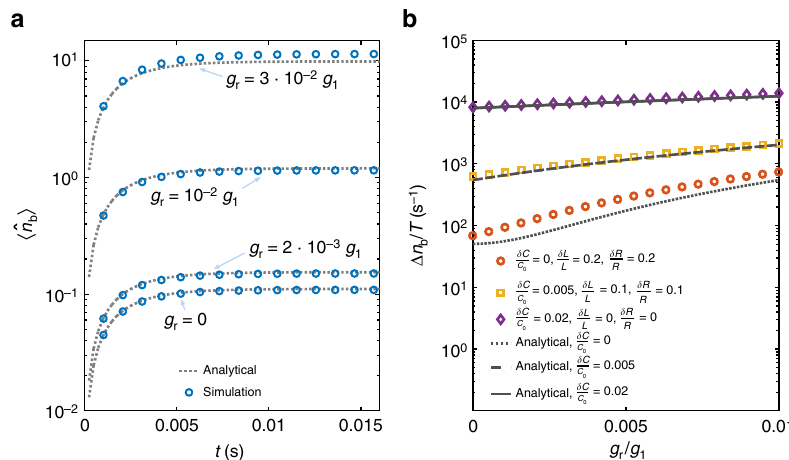
Fig. 3 Heating simulations. a Average phonon number n b ( t ) as a function of time. We present a comparison between the analytical curves (grey, dotted lines) and the full simulations of the system (blue dots). From the bottom to the top we set g r / g 1 to be 0, 2 × 10 − 3 , 10 − 2 and 3 × 10 − 2 . We use δ R = δ L = δ C = 0. b Heating rate Δ n b / T as a function of the normalized residual linear coupling g r / g 1 . Here we analyse the system in the presence of asymmetries in the parasitic elements of the circuit. The three dark grey lines are the analytical predictions for δ C / C 0 being equal to 0 (dotted), 0.005 (dashed) and 0.02 (full). The circles, squares and diamonds are the simulated results for the values δ R / R , δ L / L and δ C / C reported in the legend. We assume L / L 0 = 10 − 2 , R / Z out = 10 − 1 , ω s = (2 π )7 GHz, ω m = (2 π )80 MHz, γ r ≃ γ t = (2 π )0.15 MHz, γ b = (2 π )80 Hz, g 1 = (2 π )7 kHz, (cid:2) n